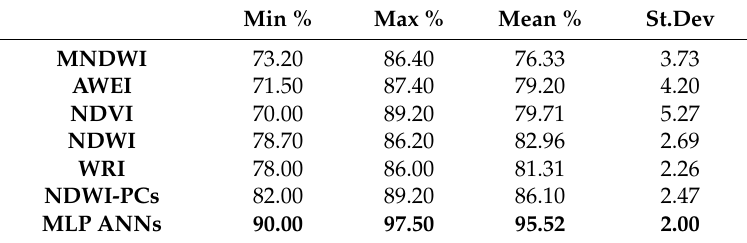
Table 2. The average values of the accuracies for different types of anomalies. Min % Max %